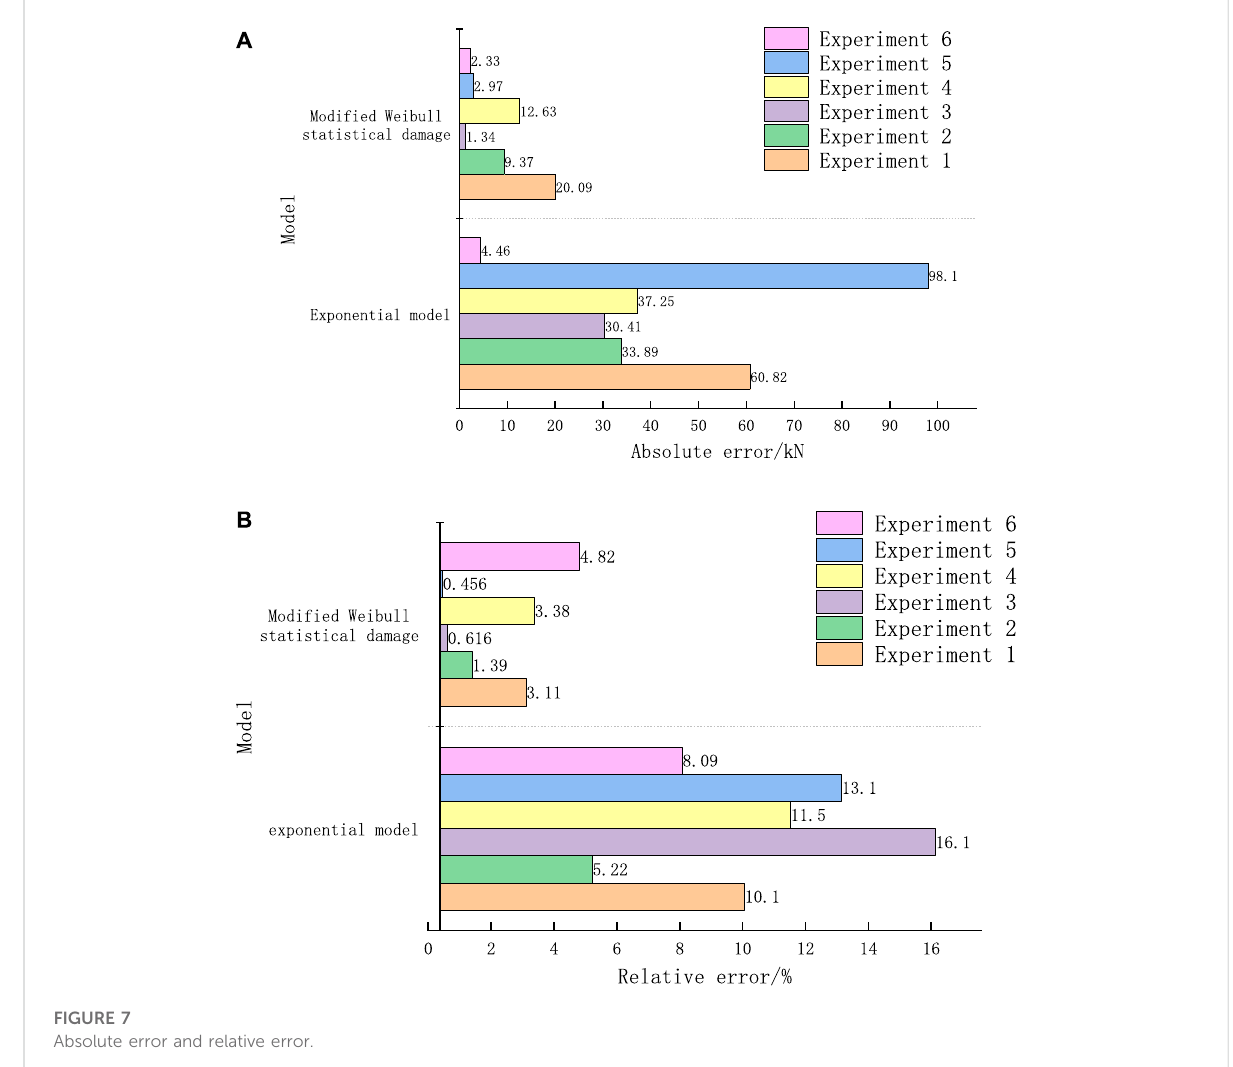
FIGURE 7 Absolute error and relative